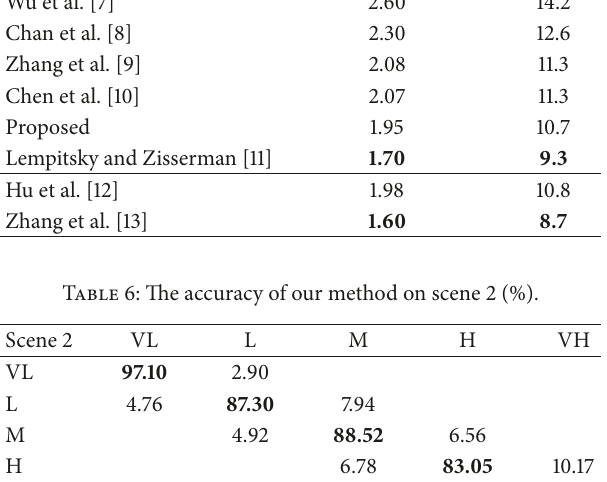
Table 5: Comparison with other algorithms on UCSD dataset. Method